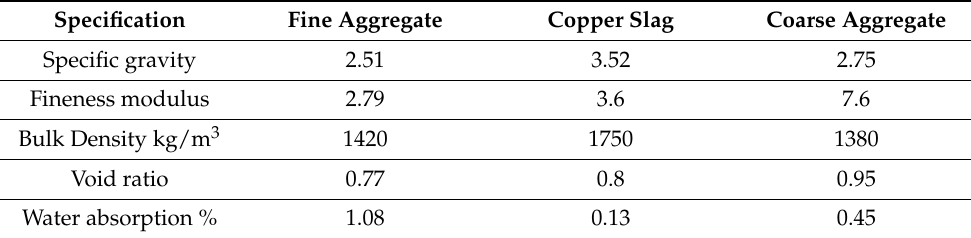
Table 2. Physical properties of fine aggregate (river sand), copper slag, and coarse